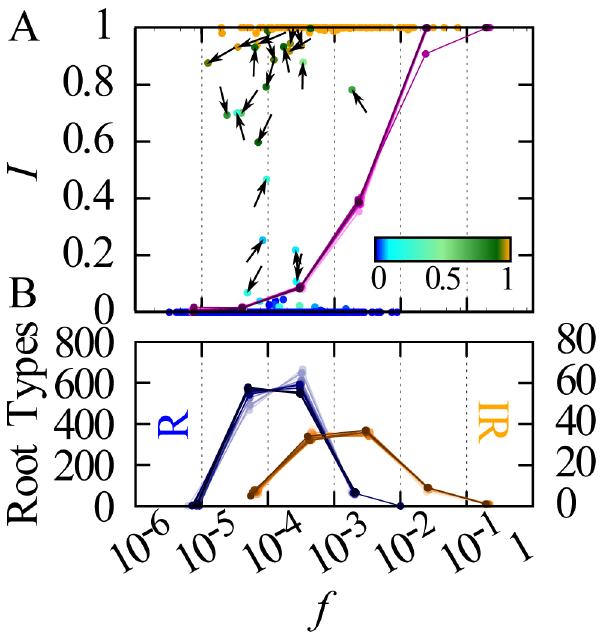
Figure 2. Relationship between frequency f and regularity in the core vocabulary. Lighter saturation of a color indicates earlier decades, while darker saturation indicates later decades. (A) Single points represent roots in the final decade (1980–1989), color-coded according to the average value of I across all 16 decades. Arrows are placed on 21 active verbs with 0 : 05 v I v 0 : 95 . The direction of each arrow indicates the trajectory from the first to the last defined occurrence in the ( f , I ) space; the length of arrows is fixed. The purple curves show the binning of both f and I in each frequency logarithmic bin, for each decade. (B) Distributions of the number of stable regular roots (left axis) and stable irregular roots (right axis) for each decade, showing separate peaks which indicate different frequency profiles.